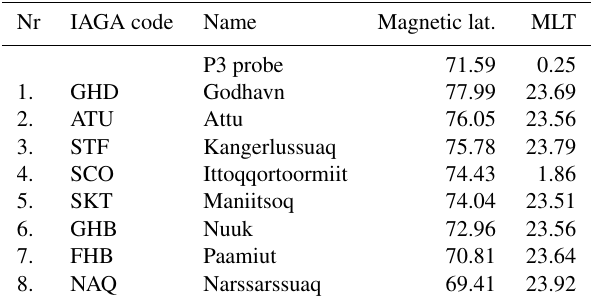
Table 1. The magnetic coordinates of the P3 probe ionospheric foot- point and the nearest ground